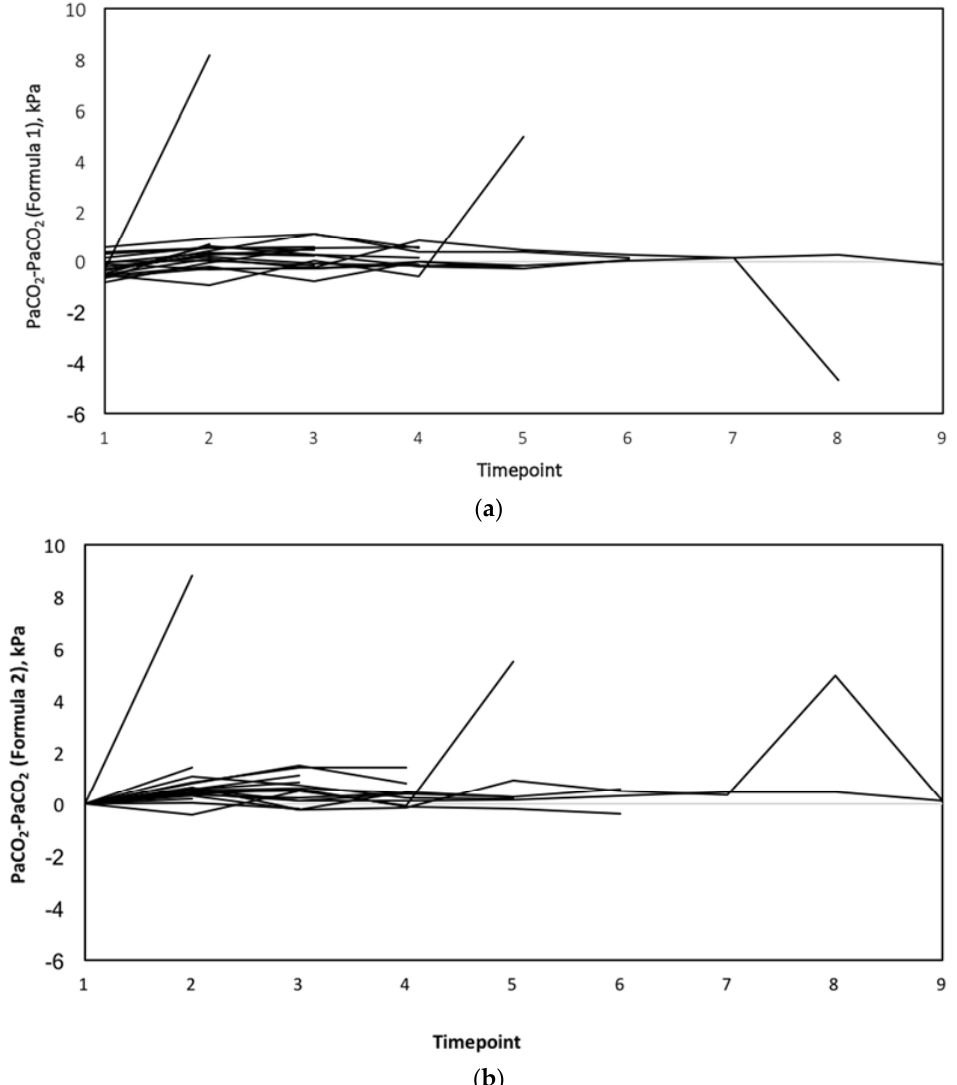
Figure 2. ( a ) The differences between estimated PaCO 2 (Formula 1) and measured CO 2 values at each time point. ( b ) The differences between estimated PaCO 2 (Formula 2) and measured CO 2 values at each time point.